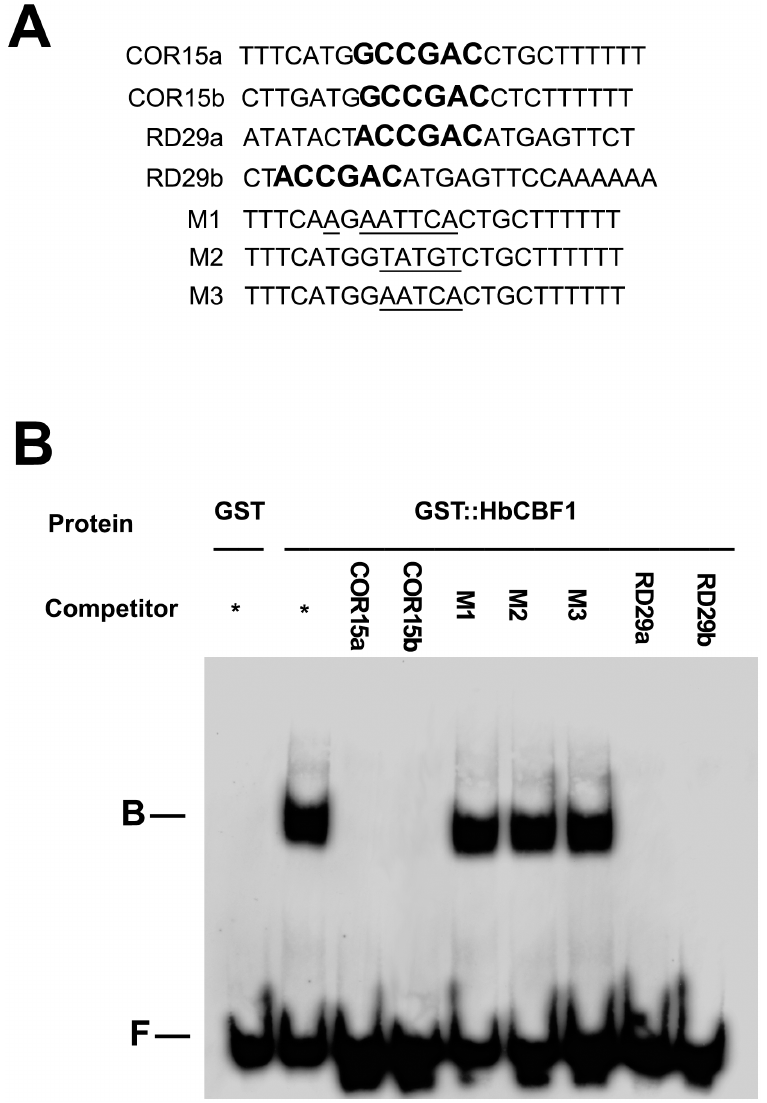
Fig 3. Gel mobility shift assay of recombinant HbCBF1 protein indicated CRT/DRE binding activity. (A) Probes sequences used in this analysis. Bolded nucleotides are CRT/DRE motif, while underlined nucleotides are the mutation sites. (B) HbCBF1 bound with CRT/DRE elements specifically in vitro . Four microgram total proteins of GST (lane 1 from the left) or GST::HbCBF1 (lane 2 – 9 from the left) were used for the binding with labeled hot COR15a probe. One hundred and twenty-five folds molar unlabelled cold competitor probes were added as indicated (labe 3 – 9 from the left) in each reactions. The retarded binding bands and free non-binding probe were indicated as "B" and "F"